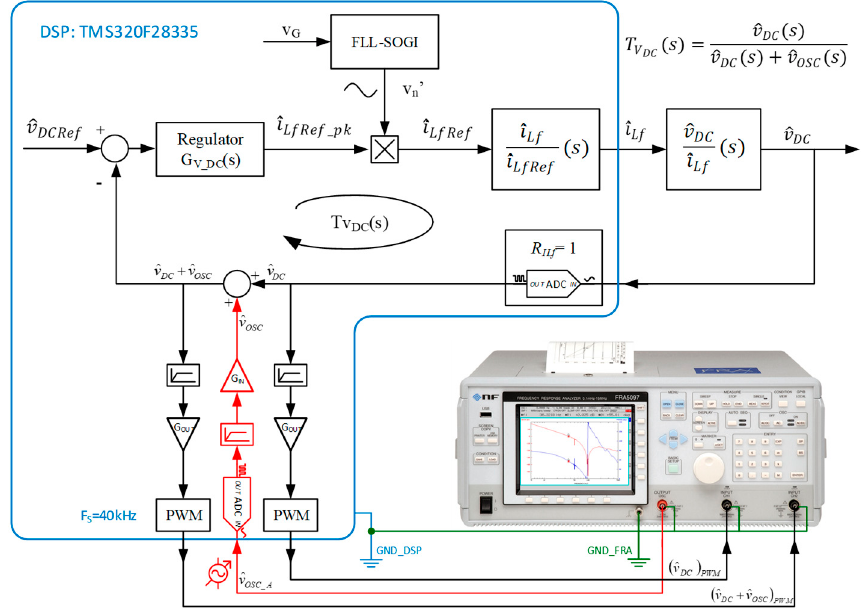
Figure 15. Loop gain measurement setup.